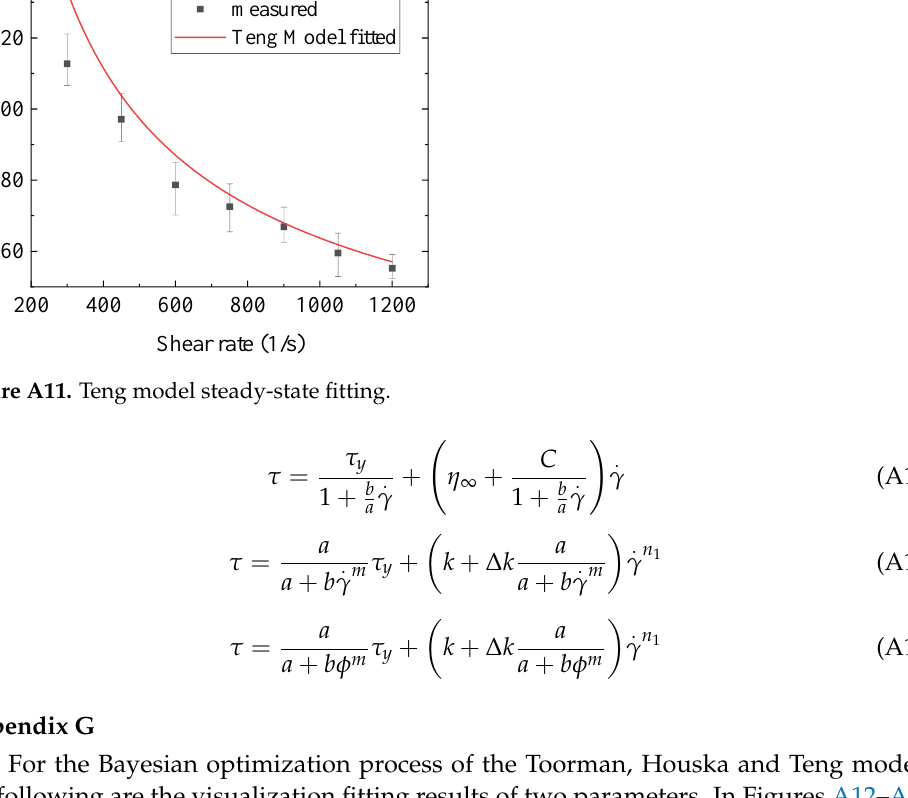
15 of 20 Figure A8. Houska model transient viscosity fitting. Figures A9 – A11 show the fitting results of the equilibrium viscosity of the Toorman, Houska and Teng models, respectively. Equations (A16) – (A18) are the corresponding equilibrium viscosity equations.